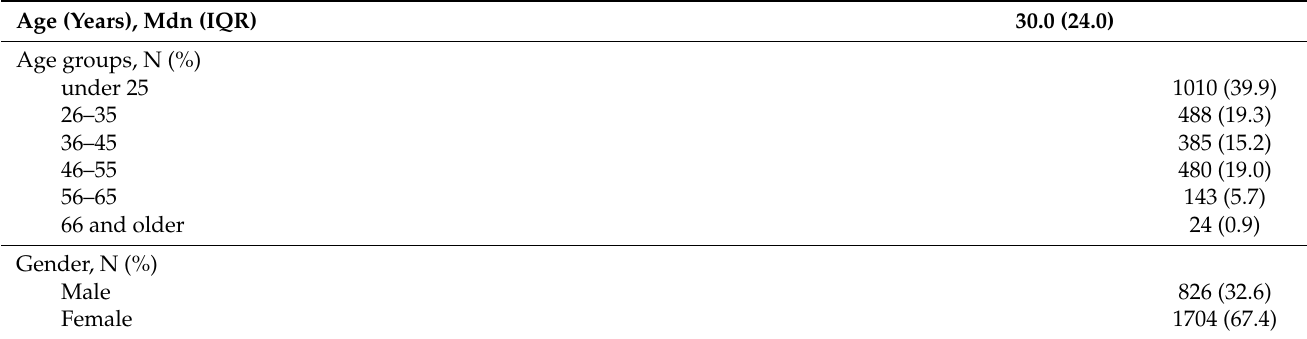
Table 1. Sociodemographic characteristics, lifestyle, and knowledge about dietary fiber and frequency of food label reading in the study group (N =